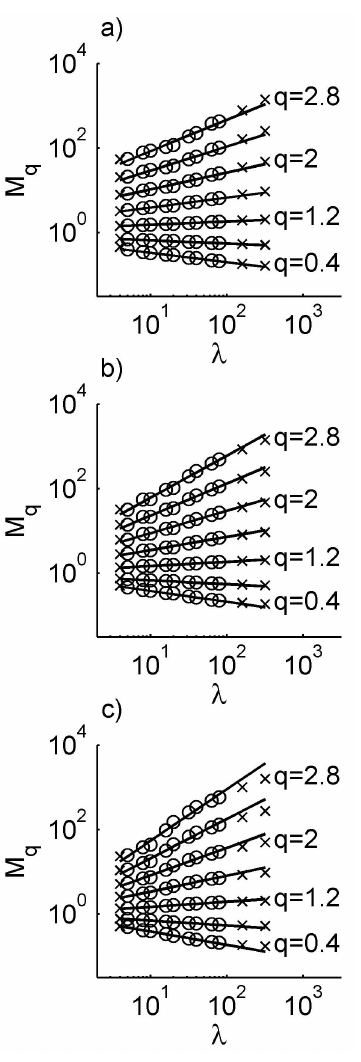
Fig. 9. Relationship between M q and λ for different values of q . M q is computed from q c at 04:00h for simulations (a) Sst5km, (b) Sst10km, (c) Sst15km. The scales considered on the analysis are marked by “o” while “x” marks the ones not considered. The plots are on log–log scale.